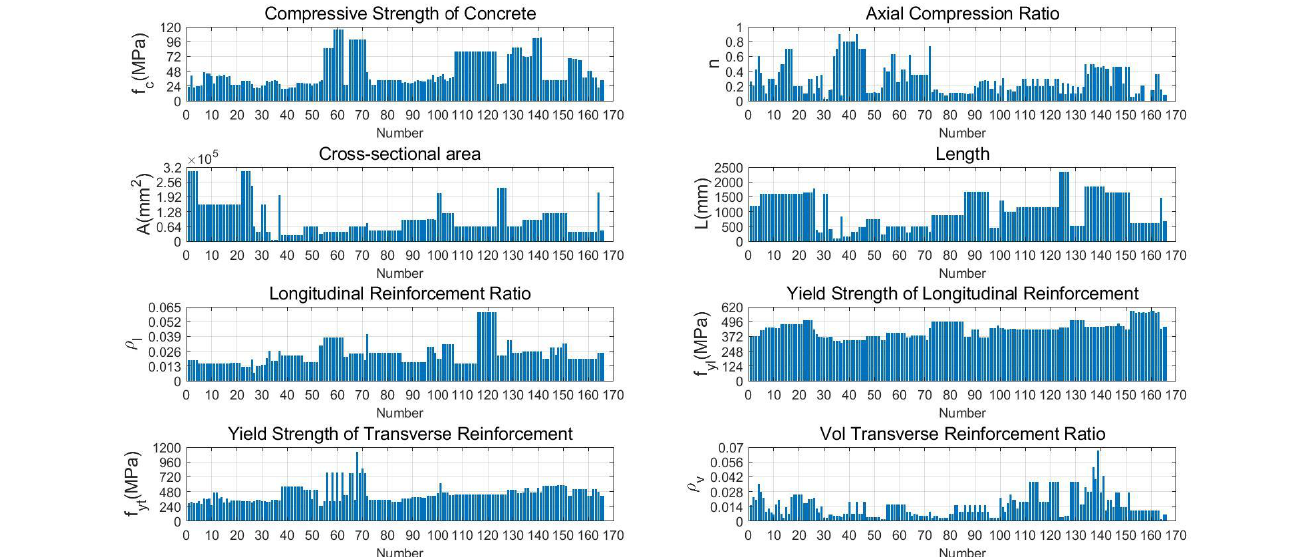
Figure 5. The values of